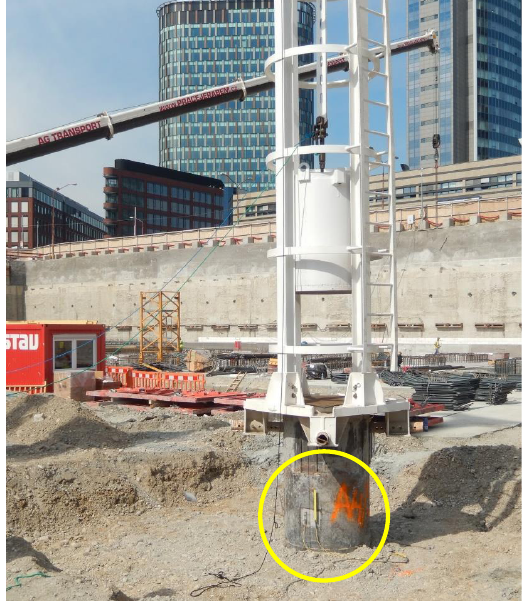
Figure 2. Dynamic load test of the pile and location of strain gauges Table 1: Permanent settlement of test piles after 5 blows with a load Pile No.